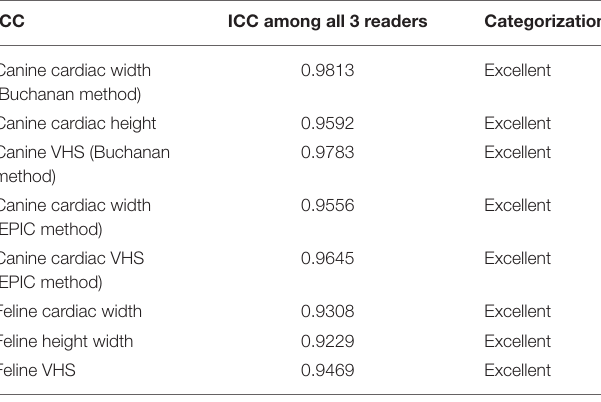
TABLE 1 | Summary table of the ICC for all the measurements performed and their respective categorization.